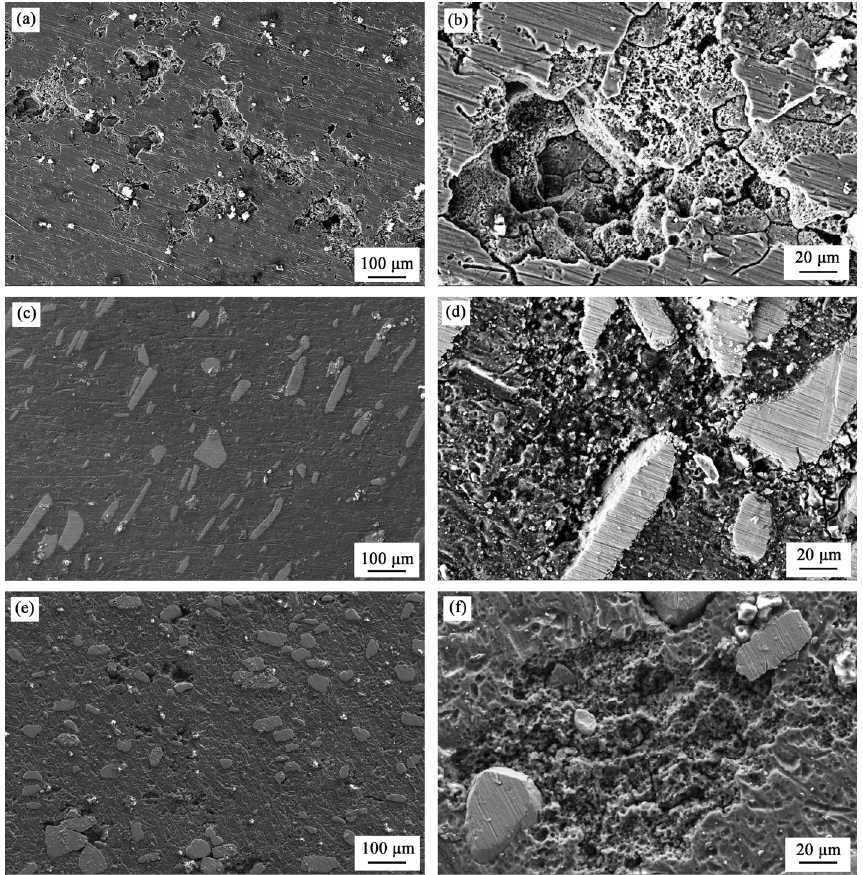
Figure 6. SEM micrographs of electrochemically corroded surfaces: ( a and b ) S000; ( c and d ) S300; ( e and f )